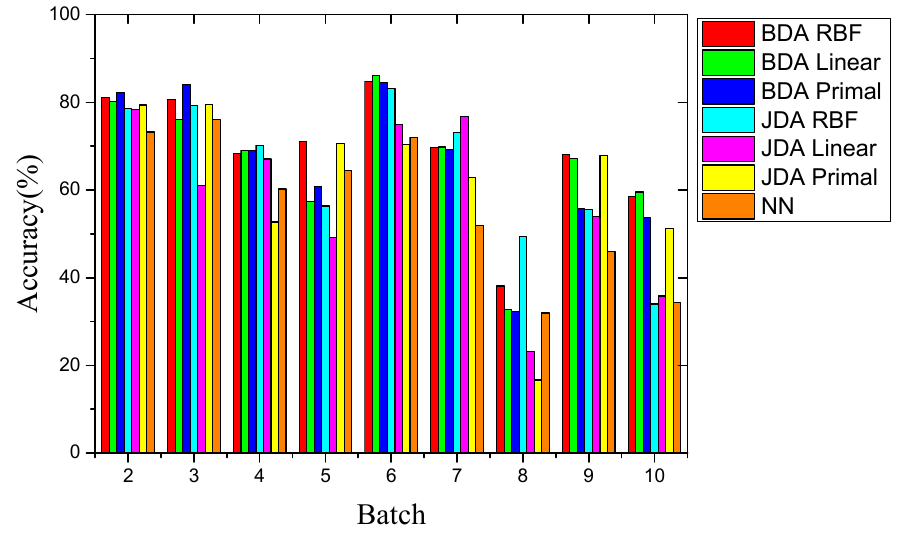
Figure 7. Comparison of recognition accuracy of different methods for Setting 1.